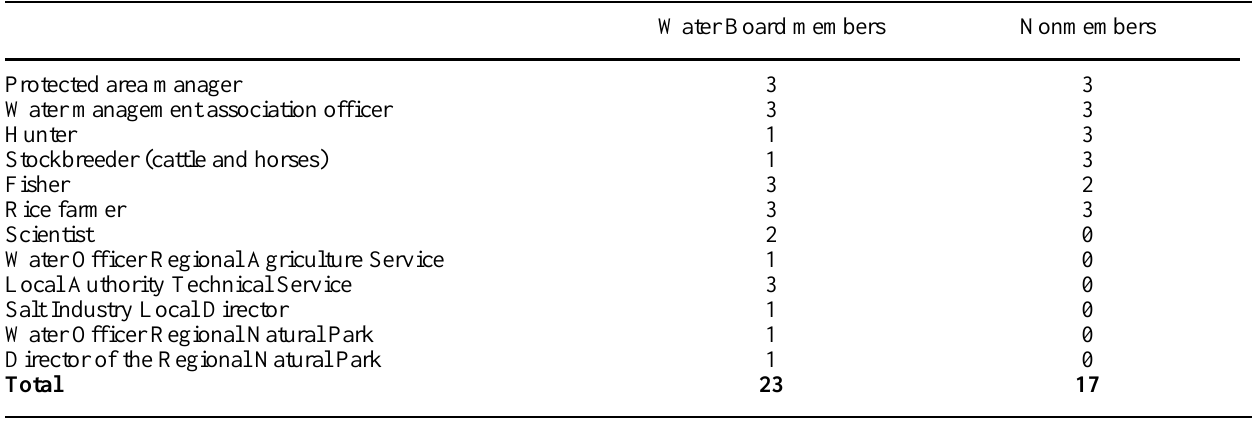
Table 1 . Socio-professional category of